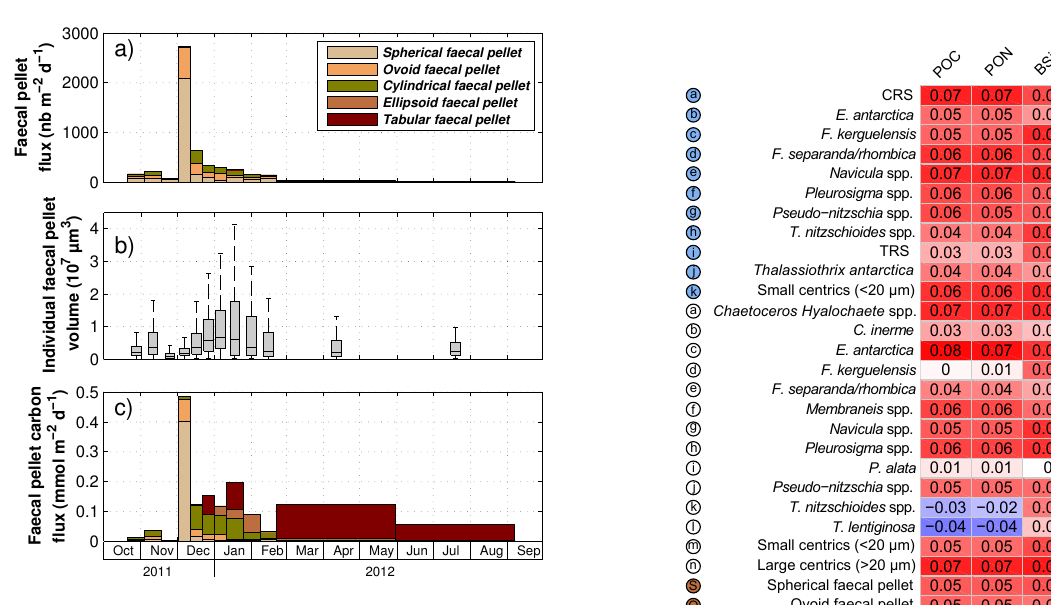
Figure 5. (a) Faecal pellet numerical fluxes partitioned among fae- cal pellet types and (b) box plot of faecal pellet volume. On each box, the central mark is the median, the edges of the box are the first and third quartiles, and the whiskers extend to the most ex- treme data points comprised in 1.5 times the interquartile distance. (c) Faecal pellet carbon fluxes partitioned between the five faecal pellet types. The two arrows represent the two strong POC export events (cup #4 and #9, December 2011 and end of January 2012, respectively).